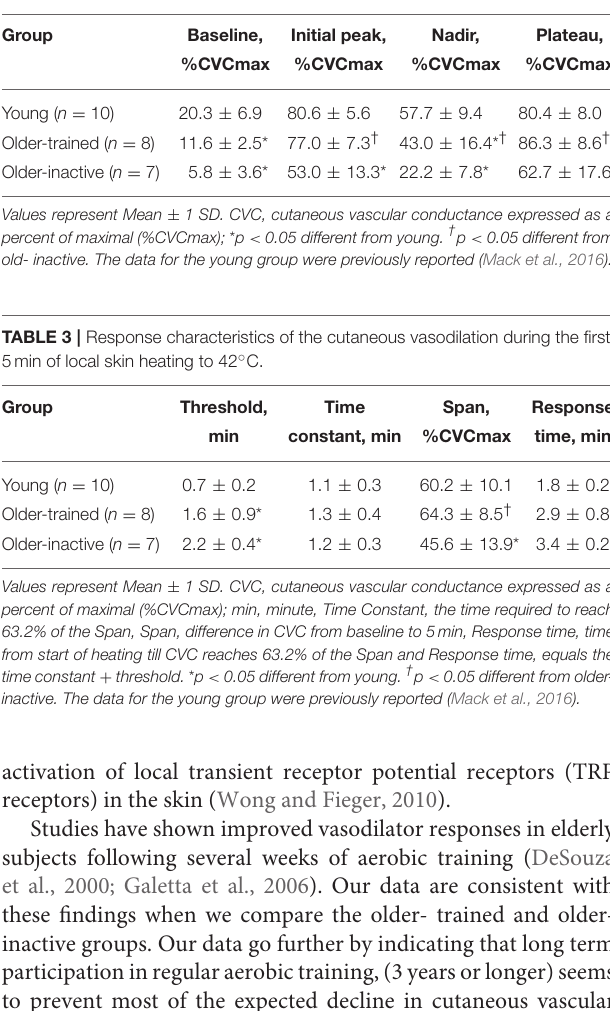
TABLE 2 | Cutaneous vasomotor response to 40min of local skin heating to 42 ◦ C. Group